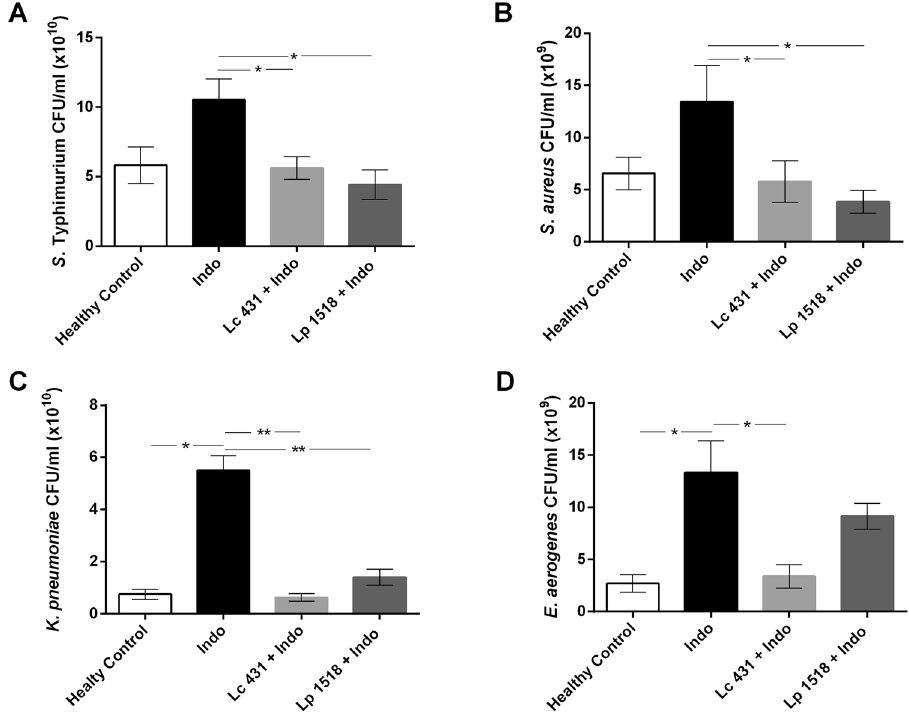
Figure 5. Antimicrobial activity of intestinal fluids of indomethacin-treated mice. S. aureus ( A ), S. Typhimirium ( B ), K. pneumoniae ( C ) and E. aerogenes ( D ), (10 9 CFU/ml), were incubated at 37 °C for 2 h in the presence of the intestinal fluids of: healthy control animals, or mice with induced intestinal inflammation receiving a conventional diet or probiotic supplementation (Indo; Lc 431 + Indo and Lp 1518 + Indo groups, respectively). After co-incubation, viable bacteria were determined by plate count agar. A set of serial dilutions were made and samples of each appropriate dilution were spread on top of solidified agar petri plates. Results (mean ± S.E.M) are representative of three independent experiments. Results were expressed as the differences in CFU/ml after and before the incubation of bacteria with the intestinal fluids. The line at the top of the bars indicates comparison between the two groups. * p < 0.05, ** p <